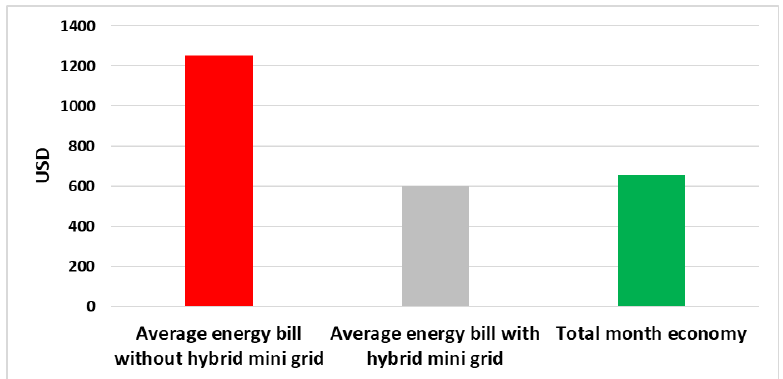
Figure 20. Estimation of the electricity bill with and without the mini-grid participation.